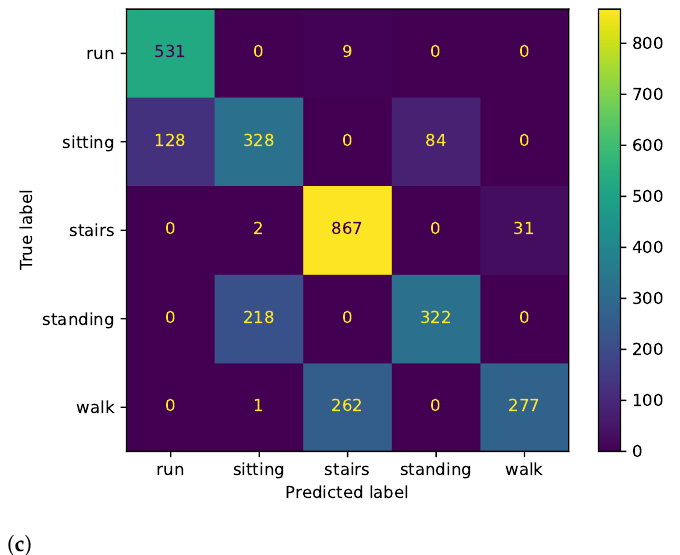
Figure A3. Confusion matrices for the SAD dataset. ( a ) In-distribution (ID). Accuracy: 99.0%, F1- score: 98.9%; ( b ) Out-of-Distribution leaving users out (OOD-U). Accuracy: 91.5%, F1-score: 91.6%; ( c ) Out-of-Distribution leaving a dataset out (OOD-MD). Accuracy: 76.0%, F1-score: